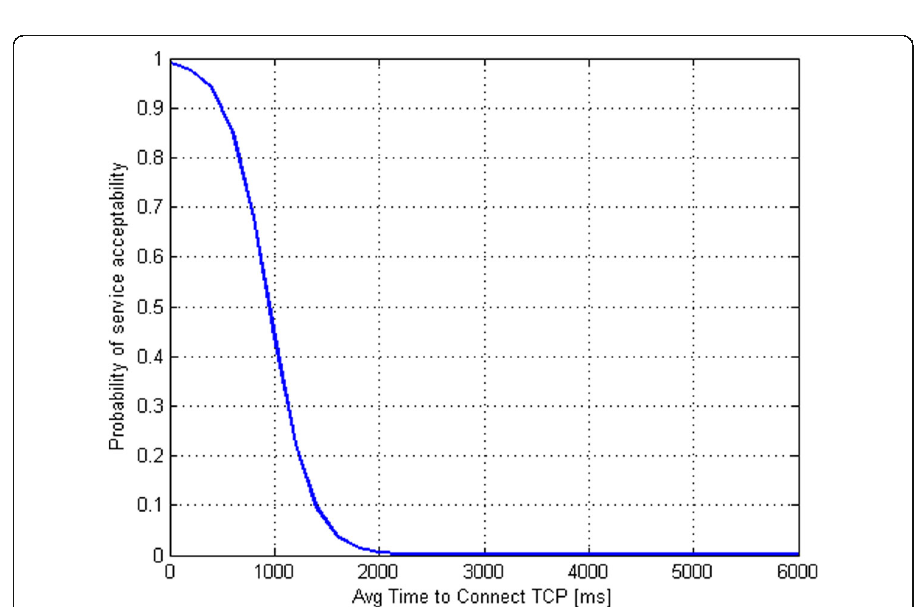
Fig. 4 Probability (x) of acceptable web service, conditioned by